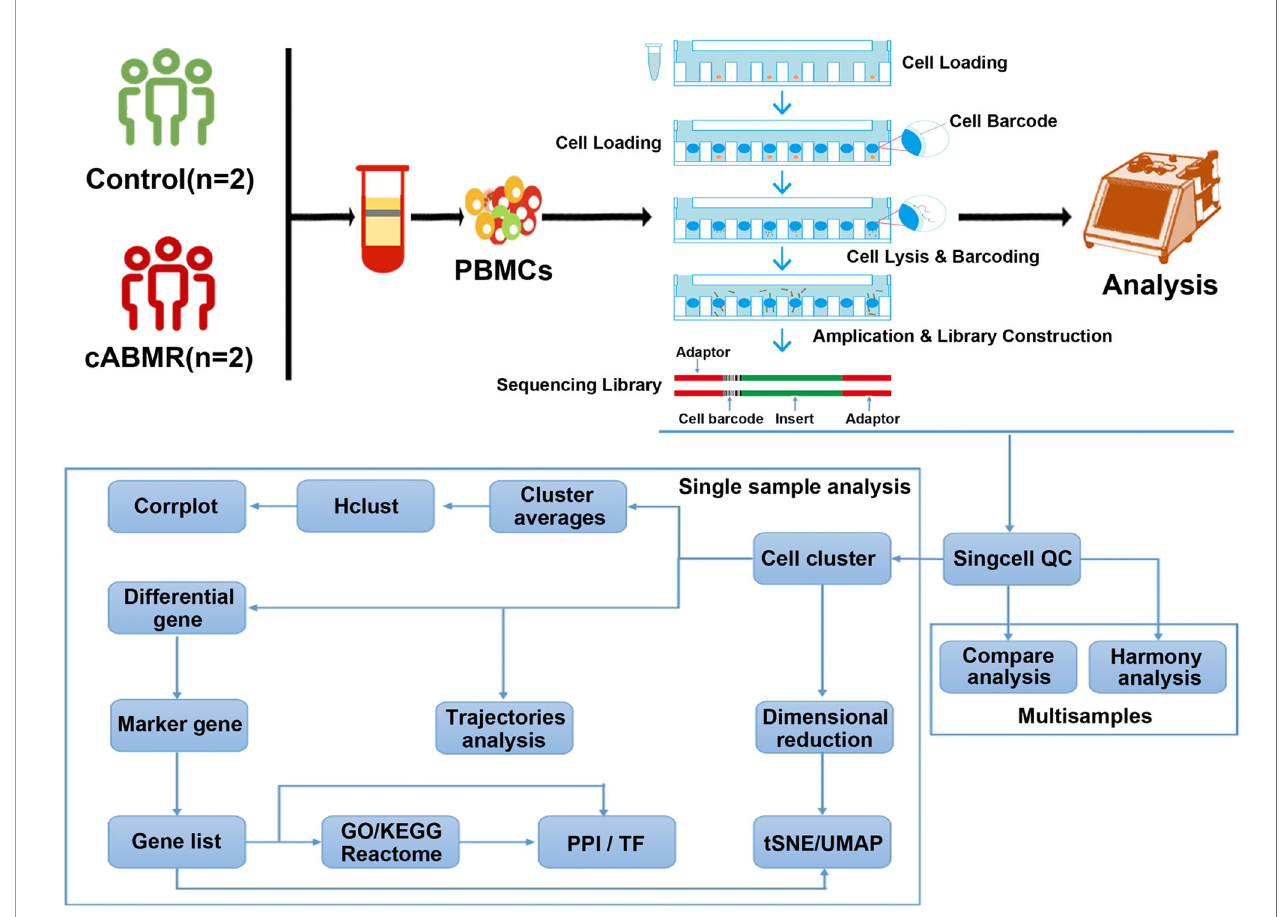
FIGURE 1 | Schematic diagram of the overall design of the research on the acquisition of PBMCs and single-cell transcriptional pro fi le analysis of normal patients and cABMR patients after renal transplantation. A total of 2 patients in the control group and 2 patients in cABMR were enrolled. After obtaining peripheral blood and extracting PBMCs, single cell suspension was obtained. To characterize the immunological features of patients with cABMR, we performed microwell-based scRNA- seq to evaluate the transcriptomic pro fi les of PBMCs 。 53,664,695 unique transcripts were obtained from 4 samples of PBMCs (a total of 39,285 cells; 23,633 (60%) from the control group and 15,652 (40%) from the cABMR group). We used the obtained sequencing data for quality control, dimension-reduction and clustering analysis, followed by cell type annotation, differential expression and GO/KEGG enrichment analysis, trajectory analysis and cell interaction